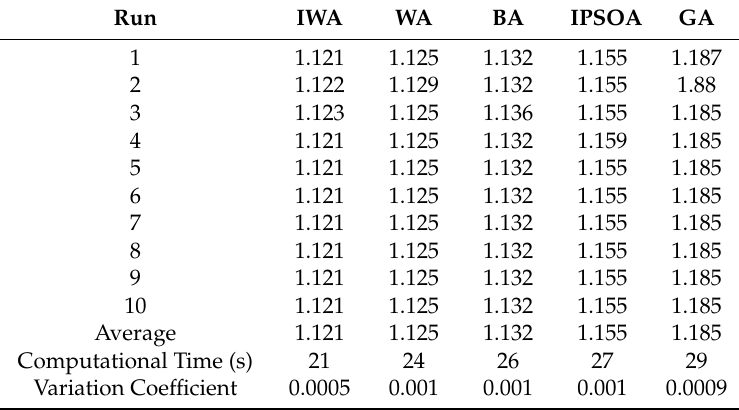
Table 8. Ten random results for low